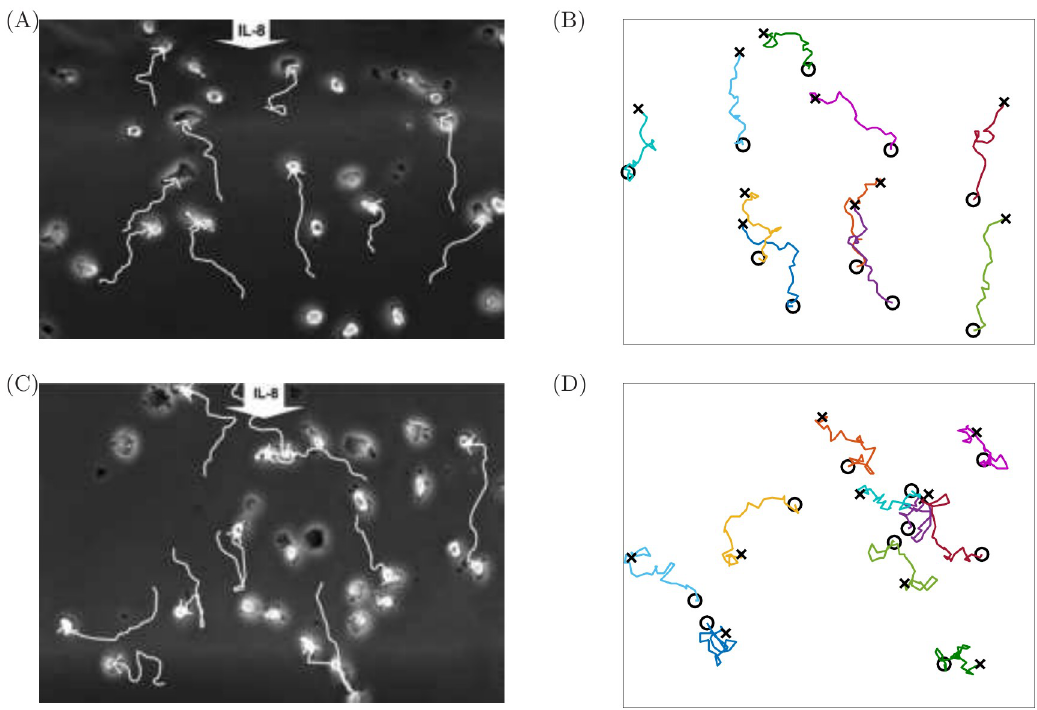
Fig 7. Comparison of the in vitro cell tracking experiments of [10] (A,C) with simulations of our calibrated chemotaxis model (B,D). In (A,B), we illustrate the healthy case, with simulations calibrated using a mean cell velocity of 3.77 μ m/min and a mean chemotactic index is 0.39, providing k grad = 80 and σ mem = 1. In (C,D), we illustrate the inflamed (COPD) case, with simulations calibrated using a mean cell velocity of 0.09 μ m/min and a mean chemotactic index is 0.04, providing k σ mem = 1.2. (A,C) Reprinted with permission of the American Thoracic Society. Copyright © 2019 American Thoracic Society. Cite: Sapey et al. (2011) ‘Behavioral and structural differences in migrating peripheral neutrophils from patients with chronic obstructive pulmonary disease’, American Journal of Respiratory and Critical Care Medicine 183(9), 1176-1186. The American Journal of Respiratory and Critical Care Medicine is an official journal of the American Thoracic